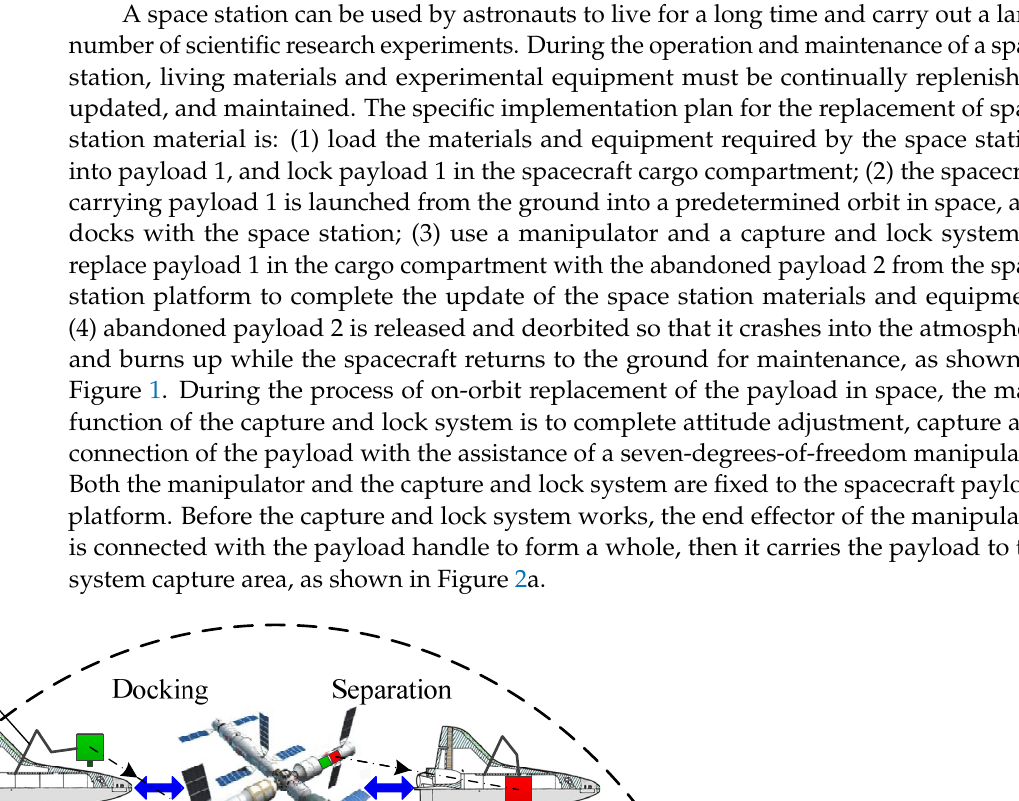
Figure 1. Schematic diagram of the space station material replacement task.